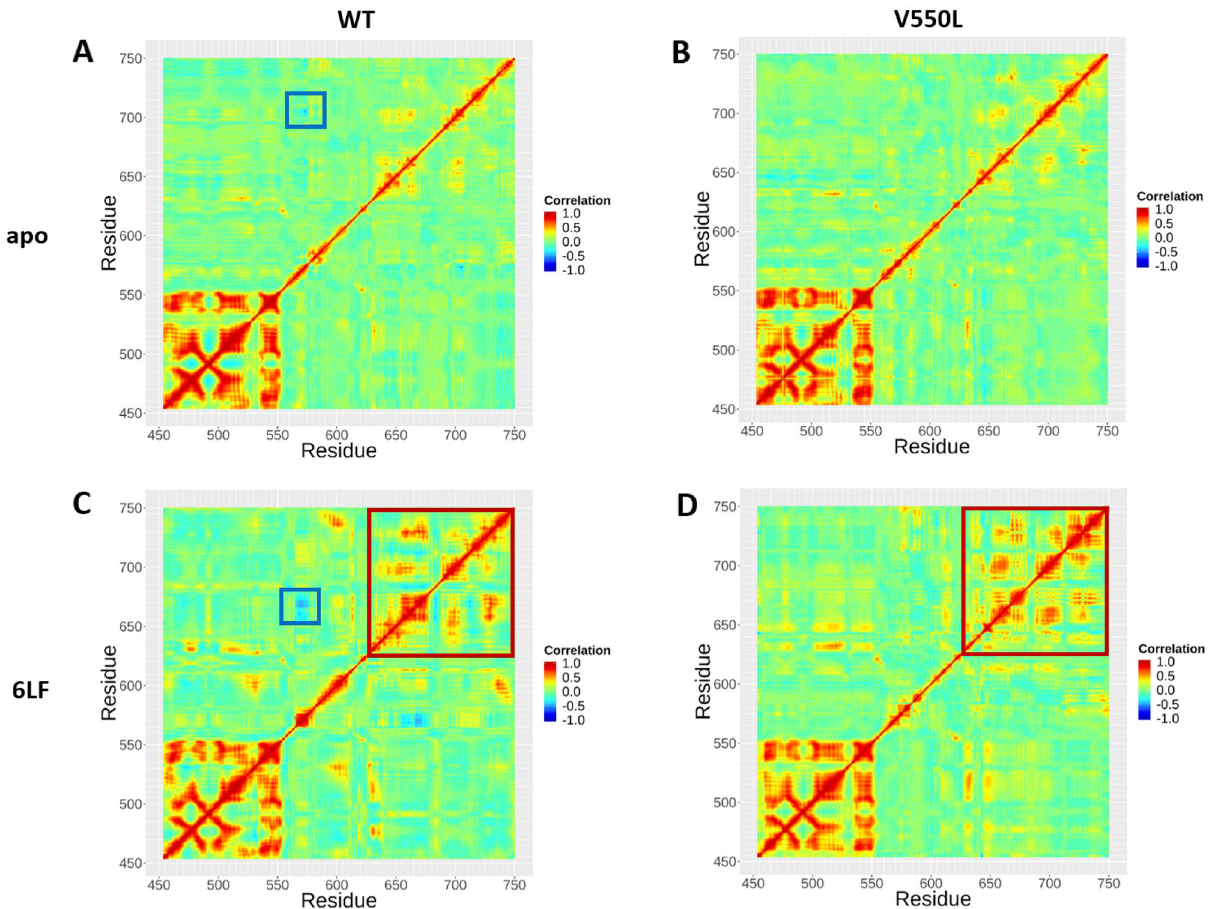
Figure 2. Dynamics cross-correlation map (DCCM) of the four FGFR4 simulations. Each dot in these maps shows a pairwise correlation of motions of FGFR4 residues. Highly positively correlated or negatively correlated motions are depicted by red or blue dots, respectively. Significant differences among the four systems are boxed (and further discussed in the text).